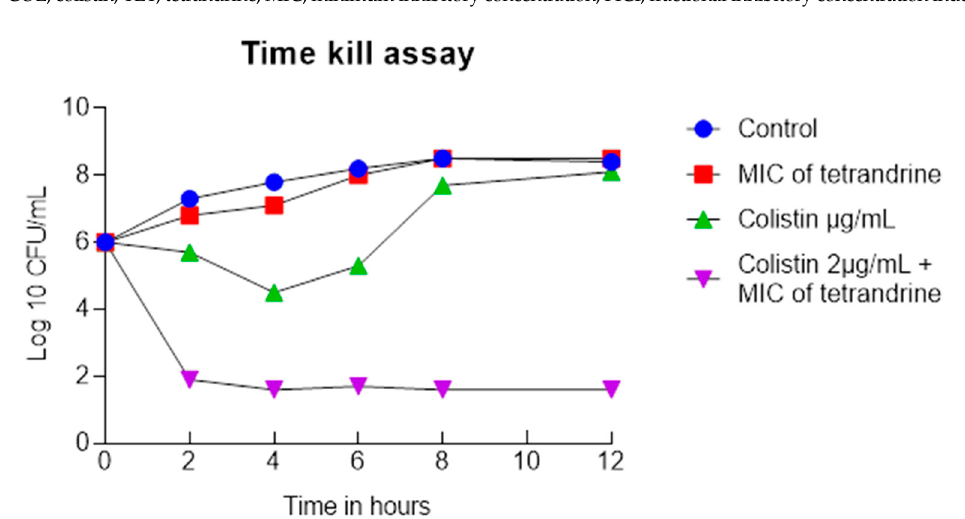
tory concentration index.